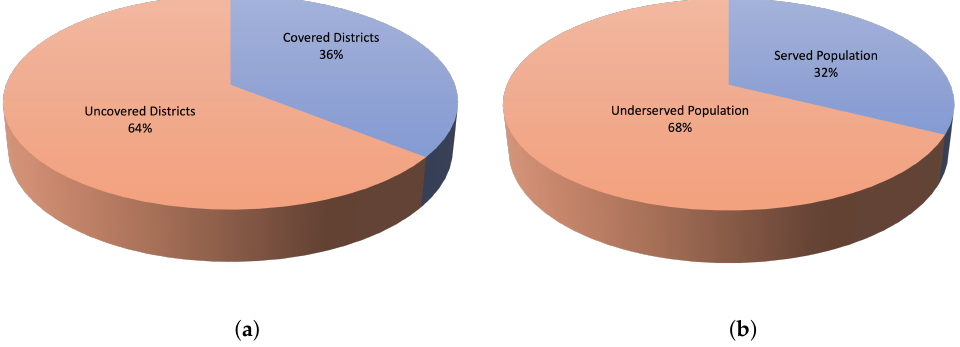
Figure 9. The percentage of ( a ) district coverage and ( b ) population coverage based on the locations of the COVID-19 vaccination centers established in 2020 in the city of Jeddah. ( a ) Percentage of the covered districts. ( b ) Percentage of the served